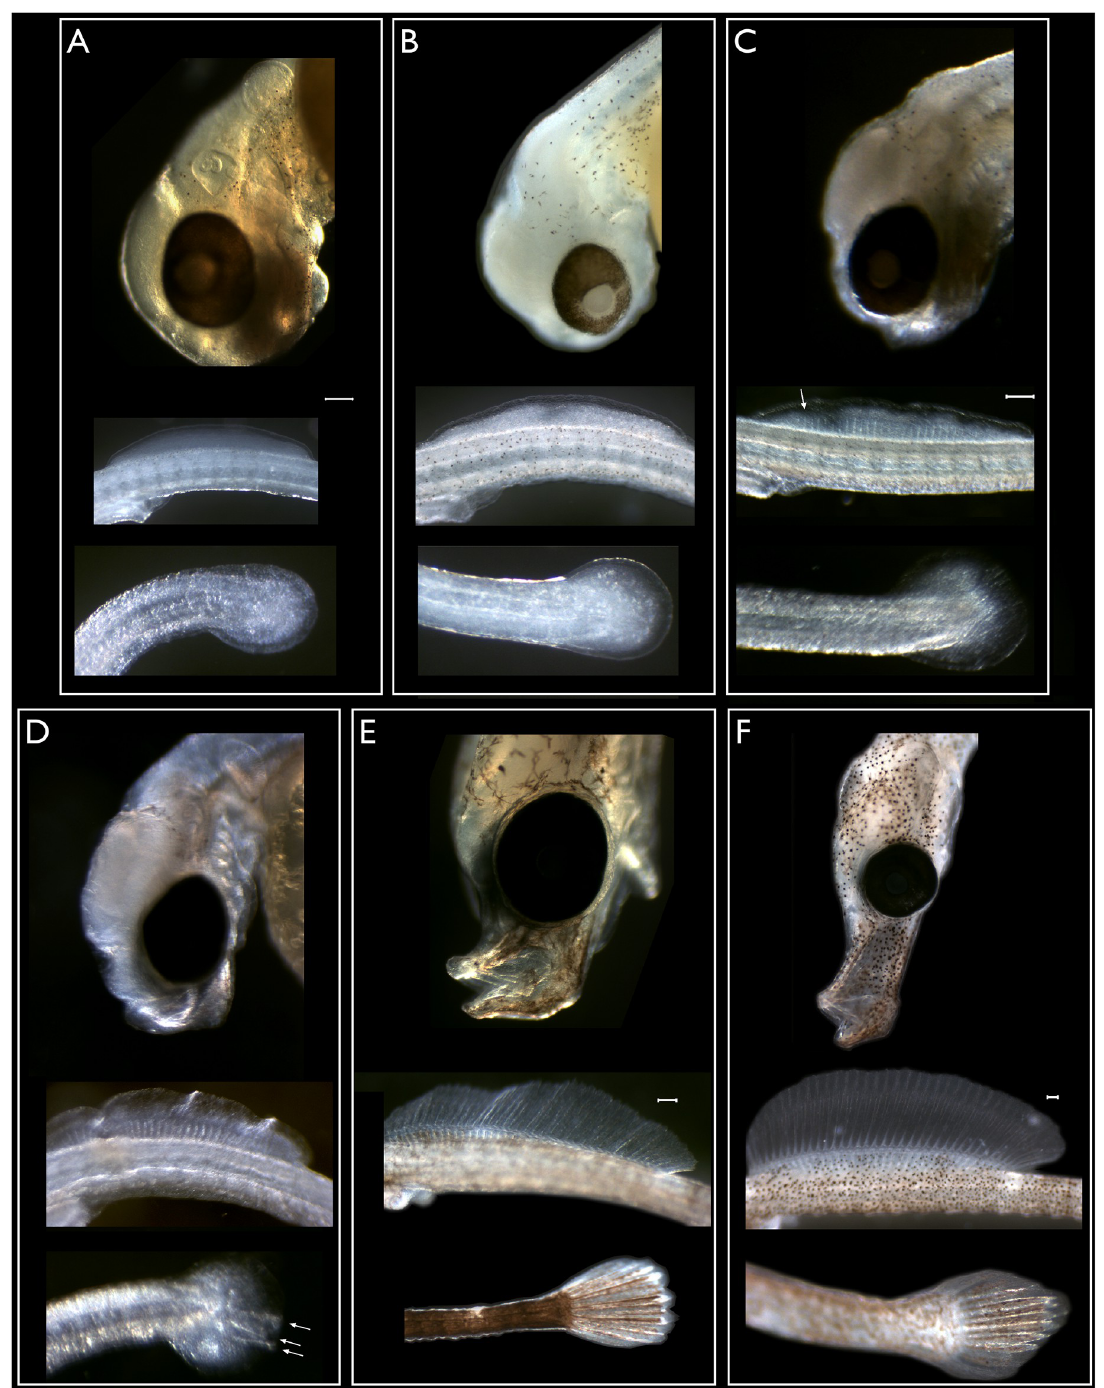
Fig 2. Anatomical features of pharyngula and hatching stage embryos. Scale bars in A, C, E and F represent 100 microns, white arrows indicate fin rays. A. Mid-pharyngula stage, no mouth, dorsal fin and caudal fin blastemas. Otolith visible. B. Similar to A, but slightly older. C. Mid pharyngula stage. Slight protuberance in future mouth region. Dorsal fin rays are emerging, no rays in caudal fin. D. Late pharyngula stage. Future snout small. Dorsal fin rays still forming, first rays in caudal fin are apparent. E. Early hatching stage. Snout distinct, jaw visible and mouth can open. Dorsal and caudal fin rays are well developed. Yolk sac is 50% absorbed. Melanocytes star shaped. F. Late hatching stage, early fry stage, shortly before emergence. Elongated snout, well developed dorsal fin. Yolk sac has been resorbed and birth is